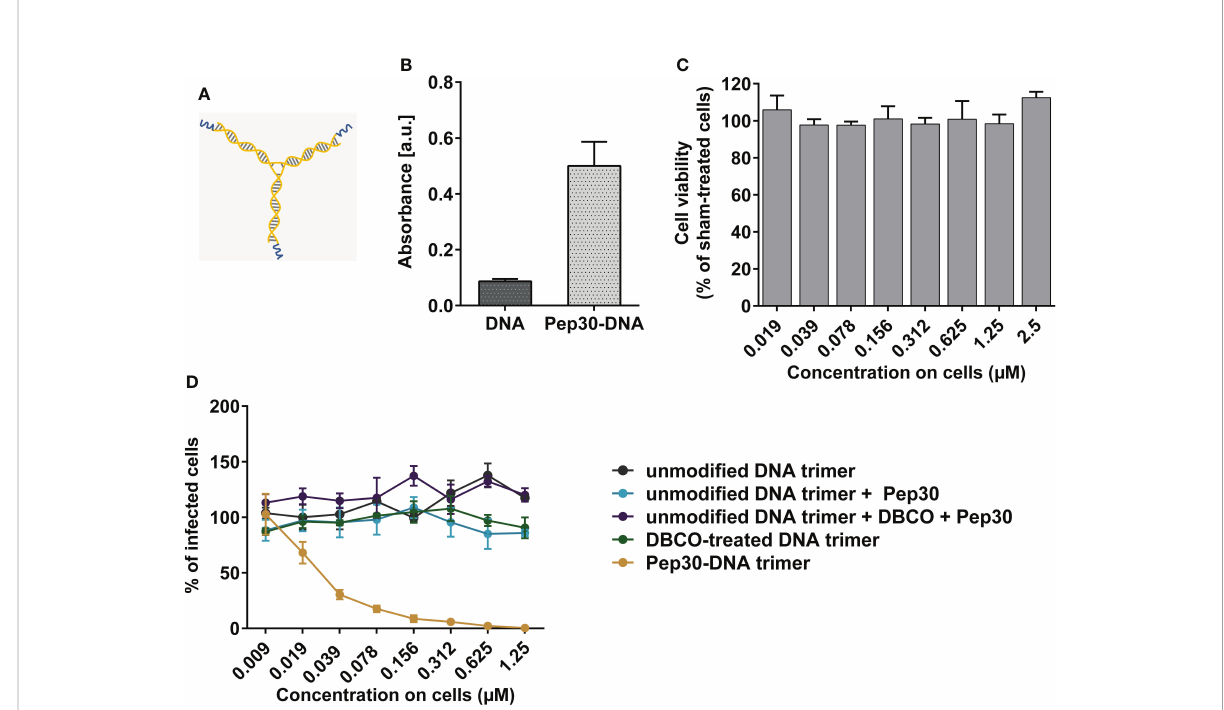
FIGURE 5 Evaluation of in vitro antiviral activity of trimeric peptide-DNA construct against RSV infection. (A) Schematic representation of the Peptide-DNA construct consisting of three Pep30 fragments (blue) attached to DNA trimer (orange). (B) Binding of dsDNA-Pep30 construct was analyzed in ELISA. Either biotin-modi fi ed 30bp dsDNA or 30bp dsDNA-Pep30 (46 nM each) was probed with HRP-coupled anti-RSV antibody and detected using TMB substrate. Shown are mean values of triplicates ± SD. (C) Analysis of the cytotoxic effects of DNA-Pep30 trimer in indicated concentrations on HEp-2 cells at 48 h post-treatment using ATP-based cell viability assay. (D) Antiviral activity of DNA-Pep30 trimer or the indicated controls measured on HEp-2 cells. Compounds were incubated with rgRSV for 10 min at 37 ° C before addition to HEp-2 cell monolayers. Viral infection was quanti fi ed at 2 dpi by counting GFP-positive cells using fl uorescence EliSpot reader. Shown are mean values of two independent experiments, each in triplicates normalized to vehicle-treated controls ±